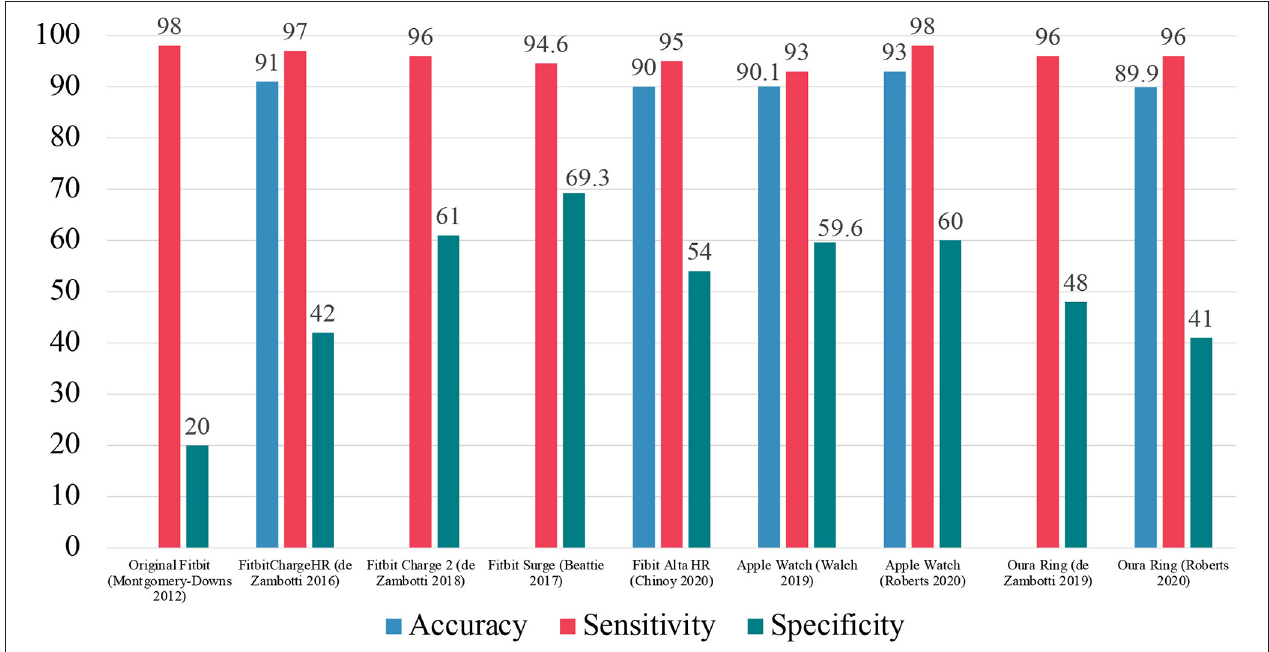
FIGURE 5 | Summary of EBE analysis for Fitbit, Apple Watch, and Oura Ring